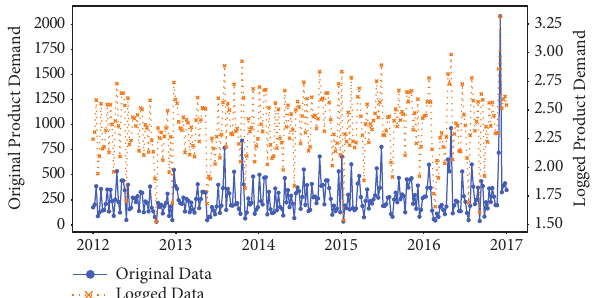
Figure 7: Comparison of the raw data before and after logarithmic processing.